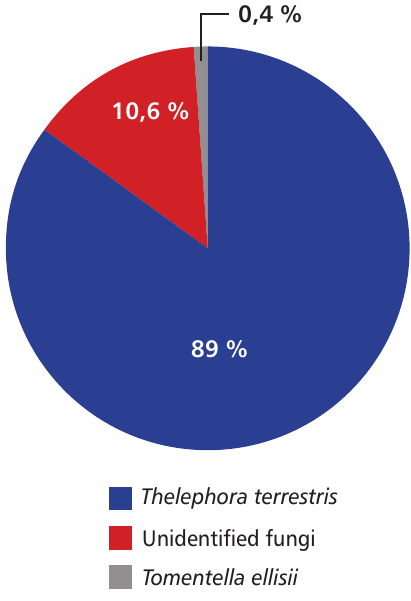
FIGURE 1. Ectomycorrhizal fungi community structure of poplars from Timok site